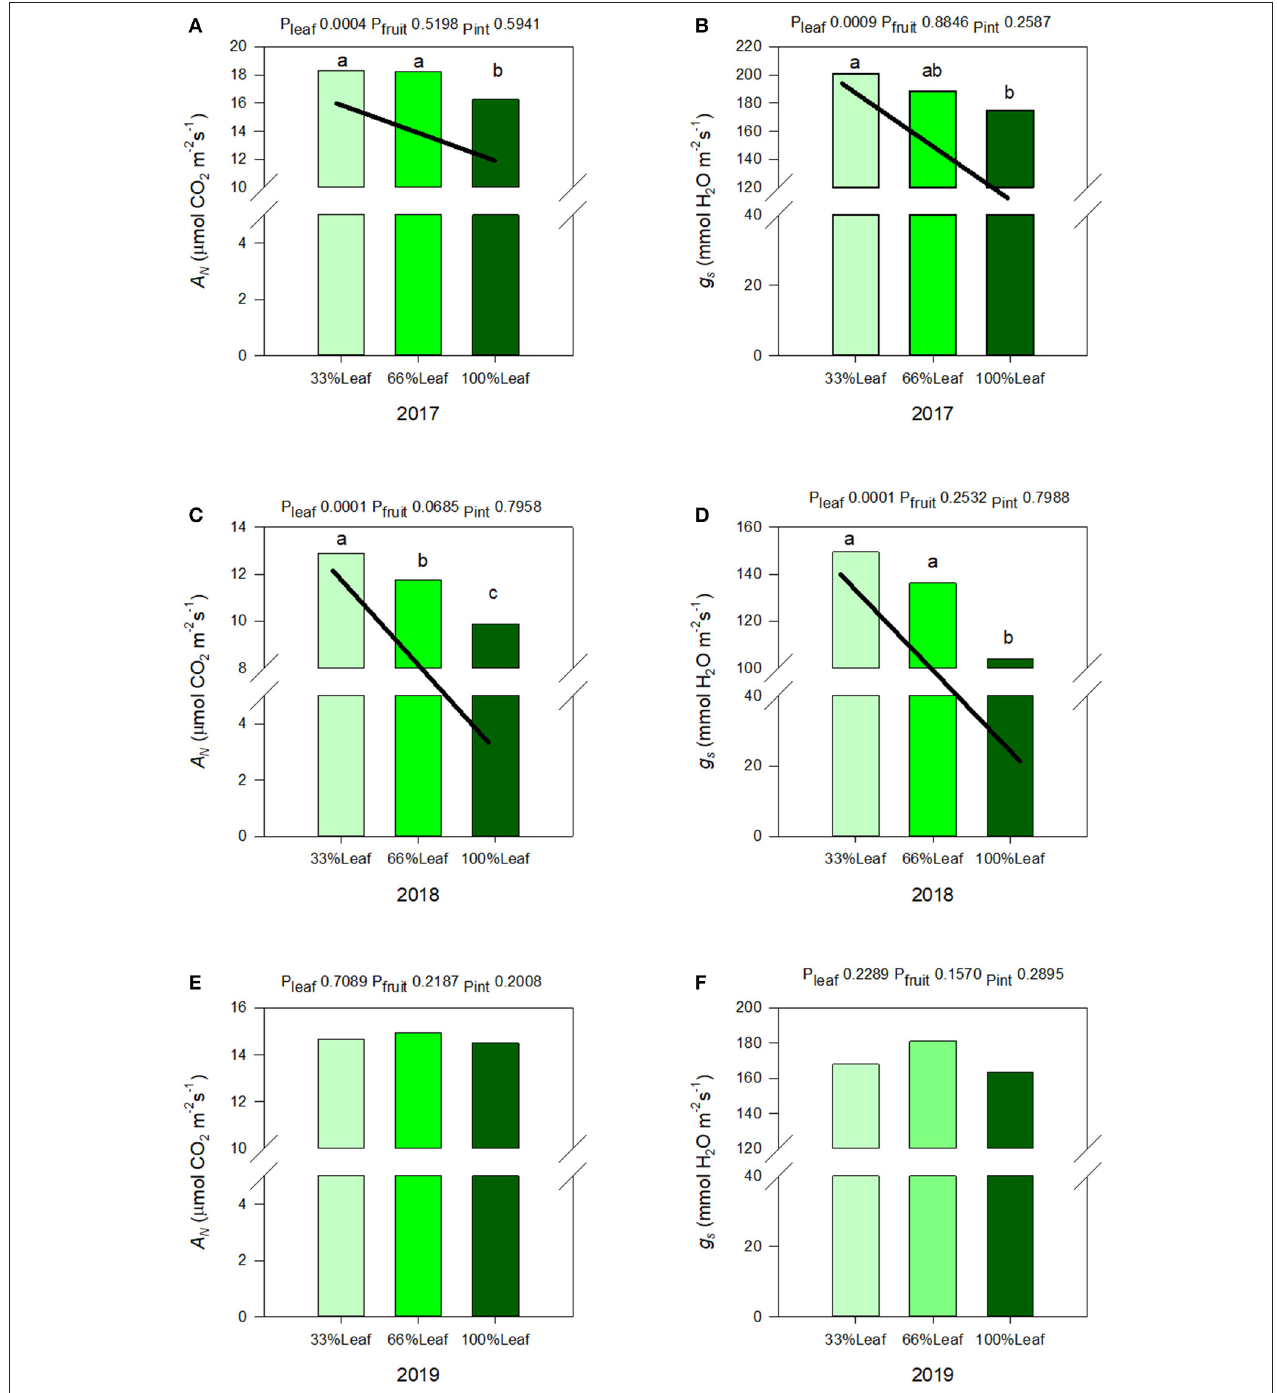
FIGURE 6 | Effect of defoliation and fruit removal on integrals of net leaf carbon assimilation ( A N ) and stomatal conductance ( g s ) of Cabernet Sauvignon in 2017 (A,B) ; 2018 (C,D) ; and 2019 (E,F) . The interactive effects and simple means with standard error of the mean in each year are presented in (A,C,E) . The main effects of defoliation with significant trend lines are presented in (B,D,F) . Columns with different letters in main effect panels are significantly different at P < 0.05 according to Tukey’s HSD. extremely different amongst treatments. These differences